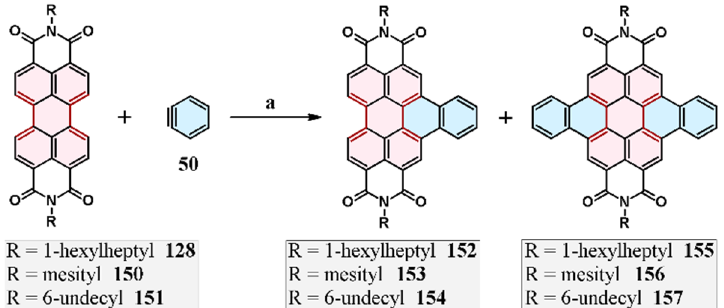
Figure 3. Synthesis of 2,3-diaryl- N , N ’-bis(2,6-diisopropylphenyl or 2-ethylhexyl)benzo[ ghi ]perylenediimides via the cycloaddition of 1,2-diarylacetylenes to N , N ’-bis(2,6-diisopropylphenyl)- or (2-ethylhexyl) benzo[ ghi ]perylene diimides bay regions: list of obtained products [152]. Y = 27% ( 146 ); 46% ( 147 ); 15% ( 148 ); and 10% ( 149 ).